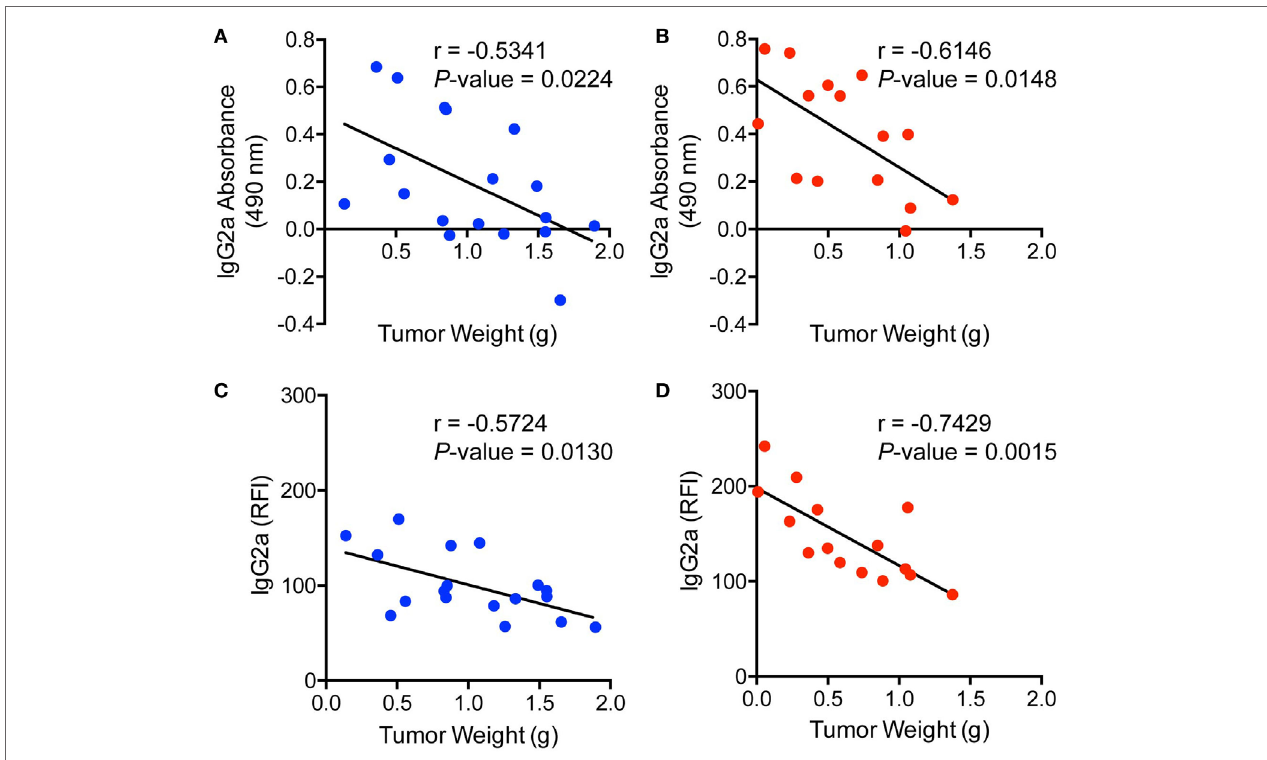
FigUre 3 | Ranitidine enhances increased IgG2a antibody production and binding which significantly correlates with tumor weight. Tumor weights from non-treated (a,c) or ranitidine-treated mice (B,D) were plotted relative to the amount of IgG2a antibody that is specific to GFP (a,B) or to E0771-GFP tumor cell-binding IgG2a (c,D) . Each dot represents individual mice and lines represent the correlation line. Correlation analyses were performed to obtain r and p